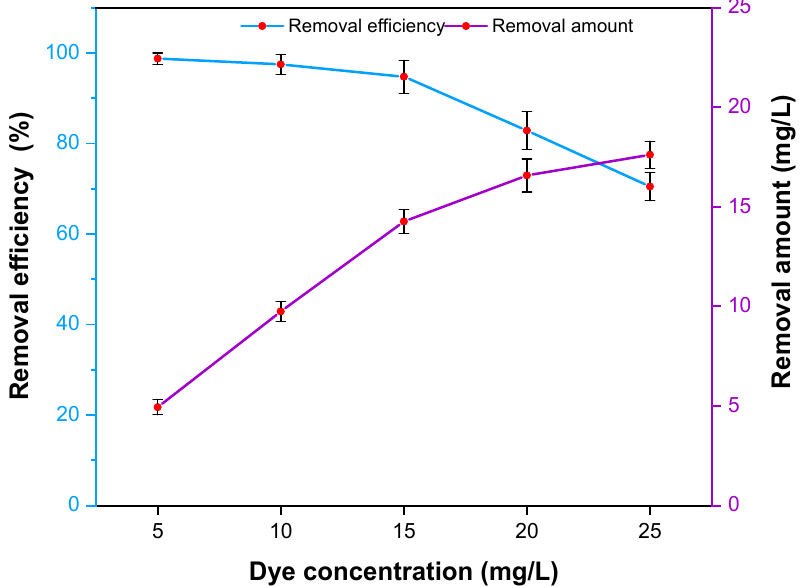
Figure 11. Effect of initial dye concentration on the photocatalytic removal of MB with B–ZnO/TiO 2 (initial MB concentration: 5–25 mg/L; photocatalyst amount: 30 mg; pH: 11; irradiation time: 15 min).